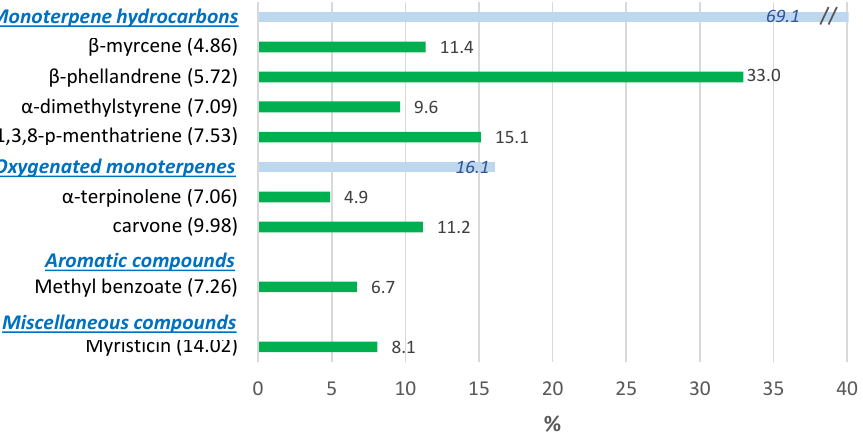
Figure 6. Volatile organic compounds (VOCs) profile of curly parsley expressed as relative percentages. Bars represent relative VOCs contents (%). Values in parentheses represent VOCs retention times.